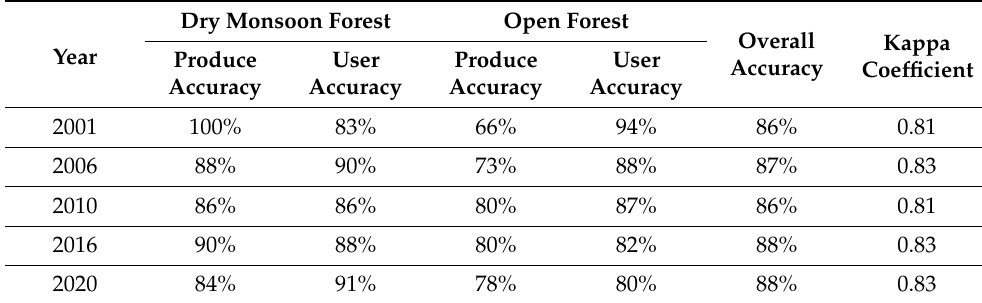
Table 6. Summary of accuracy assessment for dry monsoon and open